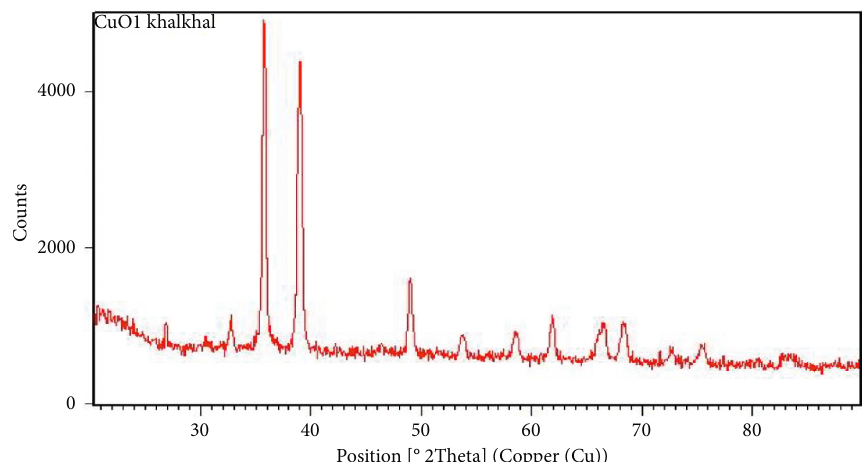
Figure 4: XRD pattern of synthesized CuO NPs using propolis (Khalkhal)